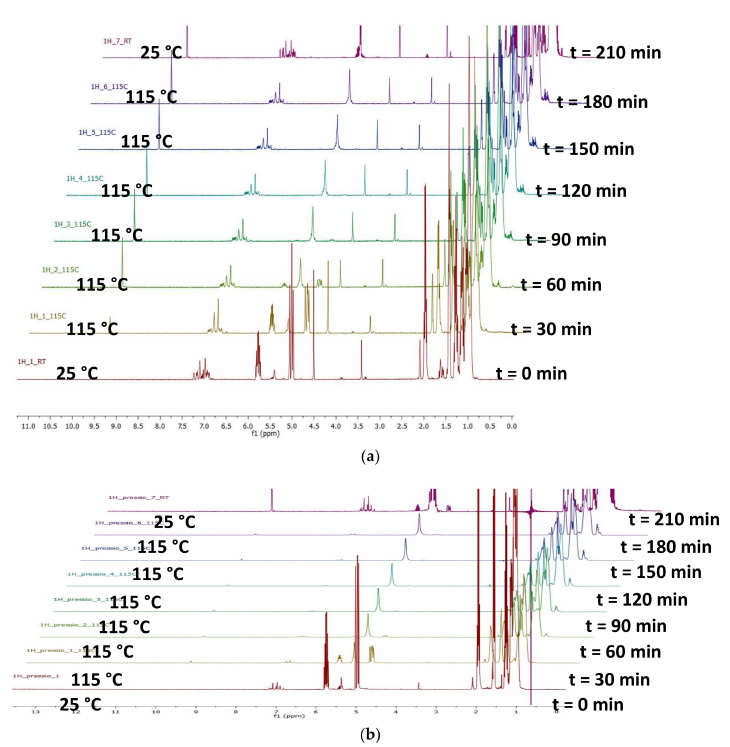
Figure A15. 1 H NMR monitoring: ( a ) [ 1 ] 0 /[Rh] = 20,000, [ 1 ] 0 = 1.0 M; and ( b ) [ 1 ] 0 /[Rh] = 3000, [ 1 ] 0 = 0.4 M (conditions: [biphephos] 0 /[Rh] = 20, P = 20 bar (CO/H 2 = 1:1), toluene- d 8 , T = 115 ◦